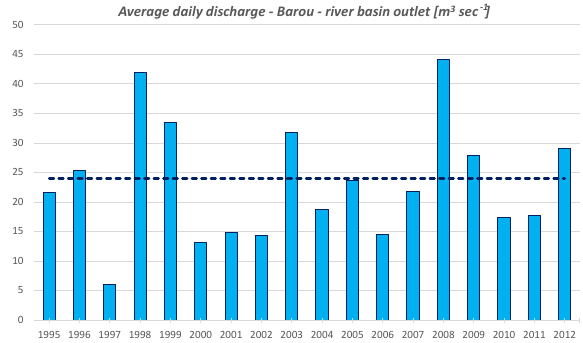
Figure 5. Daily average discharge of the Mékrou River at the Barou station, as modelled using SWAT for the period 1995–2012. The dashed line indicates the average of the total period under consider- ation. Table 5. Statistical analysis of reported number of floods and droughts during the last 10 years. Mékrou Benin Burkina Niger basin Faso Floods Mean 1.69 0.73 1.78 3.46 SD 2.07 1.16 1.43 2.64 Droughts Mean 3.93 3.83 4.80 3.36 SD 2.83 2.95 2.72